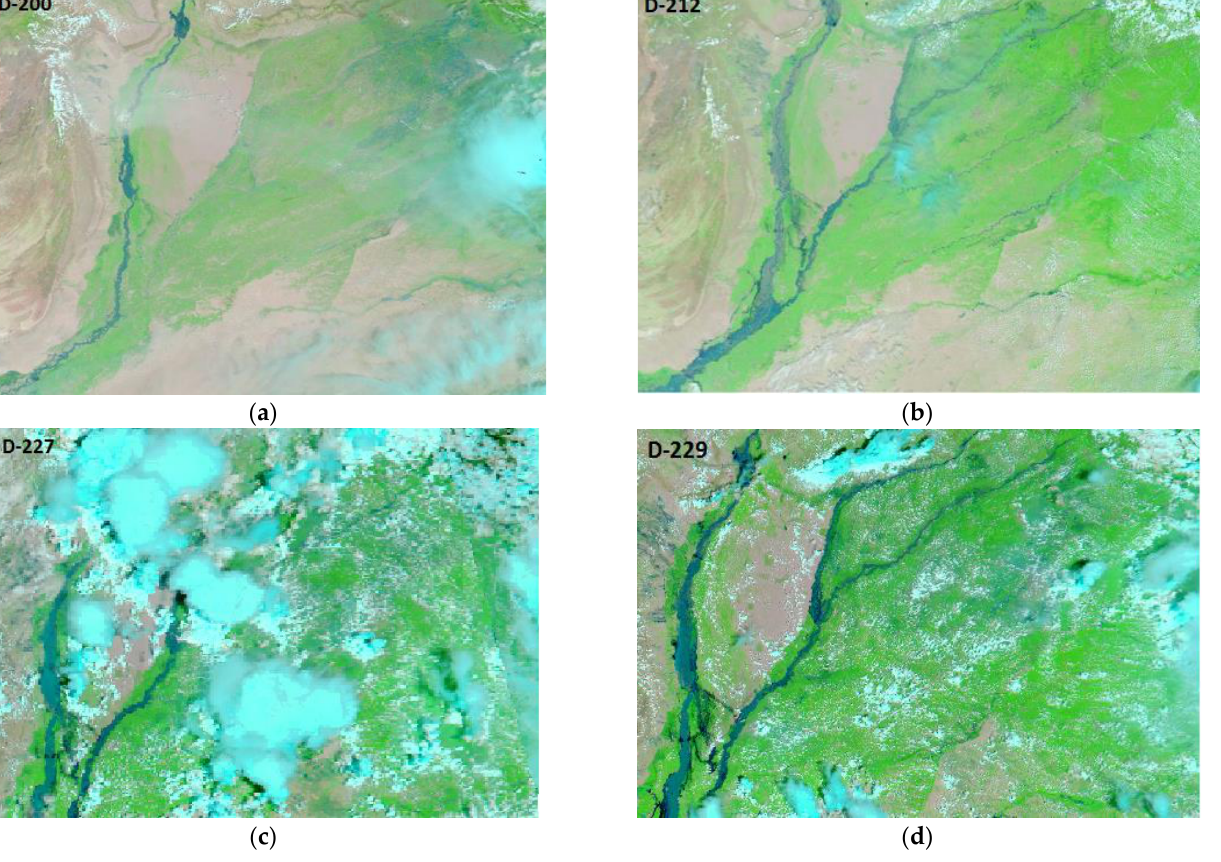
Figure 6. MODIS imagery of the flash flood from monsoon rains during 2010 at ( a ) JD-200, ( b ) JD-212, and ( c ) continuing at JD-227 as well as ( d ) at JD-229. The flowed down rapidly from the Himalayan mountain ranges (northern Pakistan) and muddy water swept over the southern plain of Punjab.